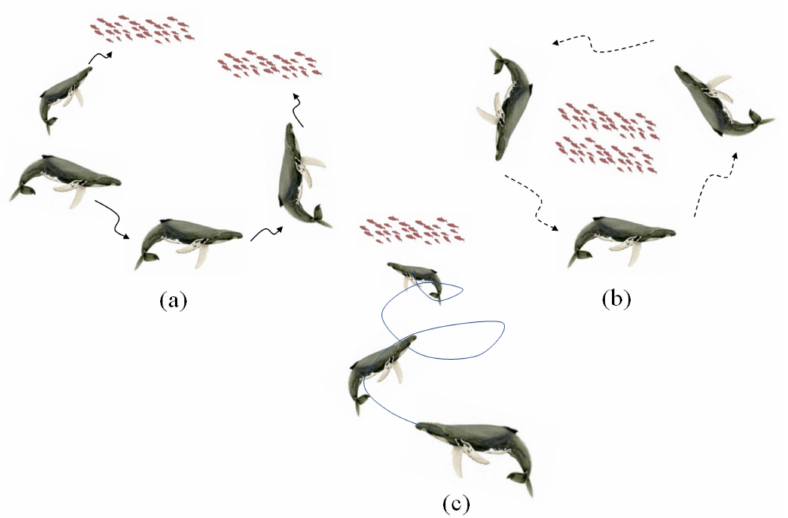
Figure 5. Hunting process of humpback whales: ( a ) movement of whales in a random direction or toward leader; ( b ) encircling process after finding the prey; ( c ) reaching the prey in spiral